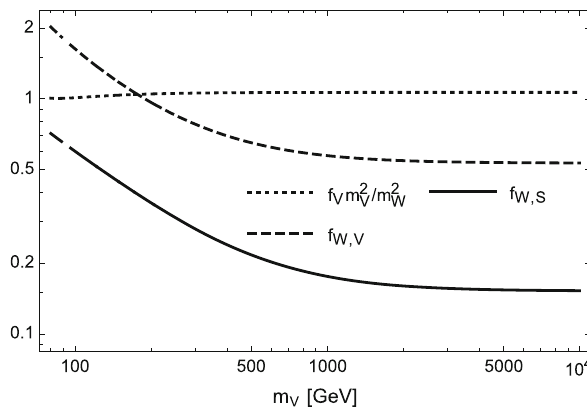
/ m 2 , f W , S and f W , V as functions of the SU ( 2 ) R scale V W